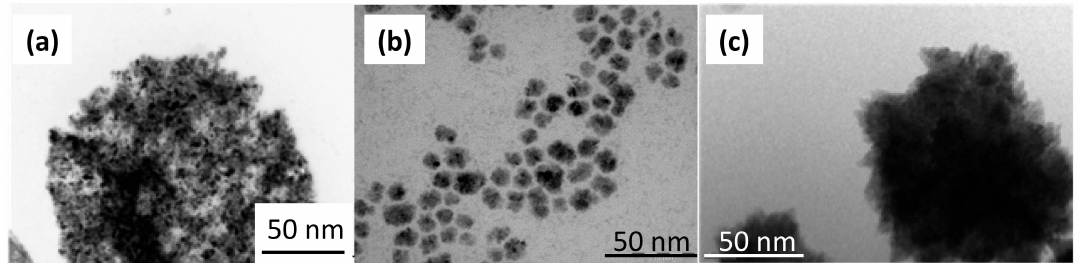
Figure 1. Transmission electron microscopy (TEM) images of ( a ) ZnO, ( b ) CdS-1, amd ( c ) CdS-2 after contact with Seine river